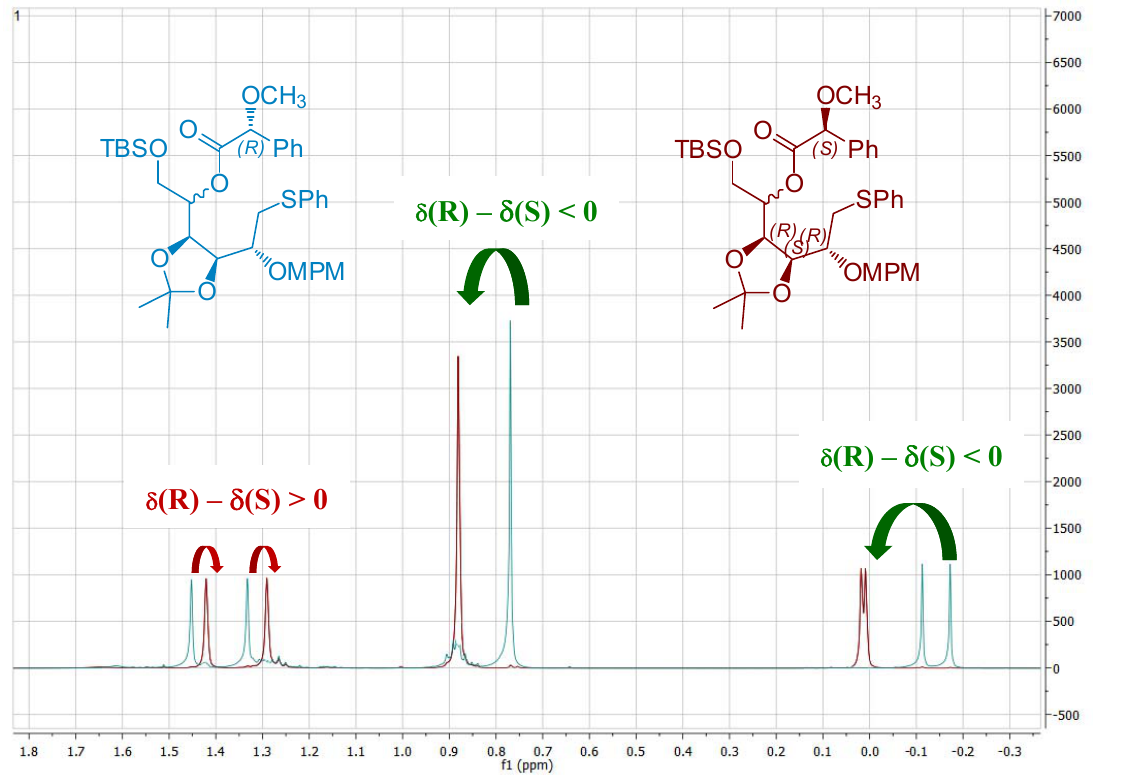
Figure 5. Comparison of selected 1 H-NMR spectra of MPA ester derivatives of 14